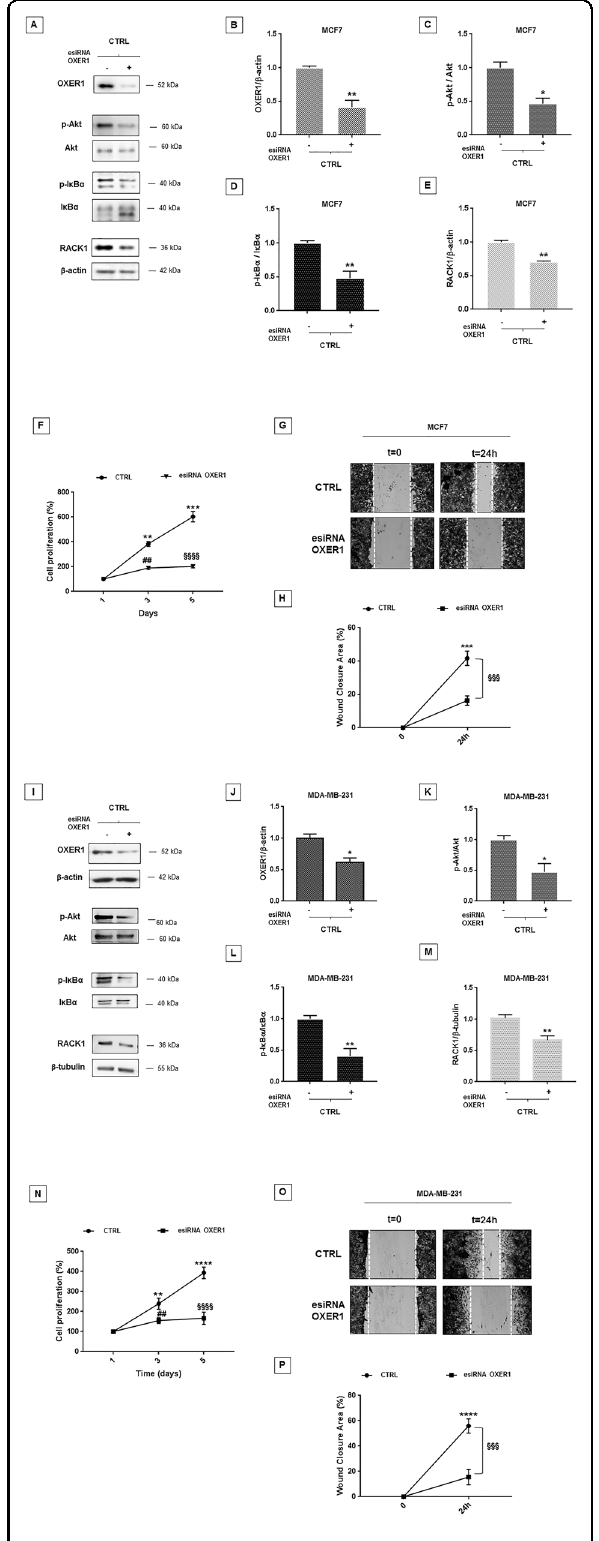
correlation-value, indicating the existence of a weak co- regulation (Suppl. Fig. S4). Given the potential role of OXER1 and RACK1 in BC progression, we evaluated the possibility that expression of the two corresponding mRNAs represent a useful predictive marker of survival for speci fi c subtypes of mammary tumors. Hence, we determined possible cor- relations between OS and the levels of OXER1/RACK1 mRNAs in the ER + , HER2 + and triple-negative (TN) BC subgroups (Suppl. Fig S5). To conduct these analyses we divided the TCGA breast cancers in OXER1-high or RACK1-high and OXER1-low or RACK1-low tumors according to a threshold value represented by the median expression levels of the two transcripts (Suppl. Fig. S5). The results of this analysis demonstrate that there is no signi fi cant difference in the OS of OXER1-high and OXER1-low tumors as well as RACK1-high and RACK1- low tumors, regardless of the mammary tumor phenotype.